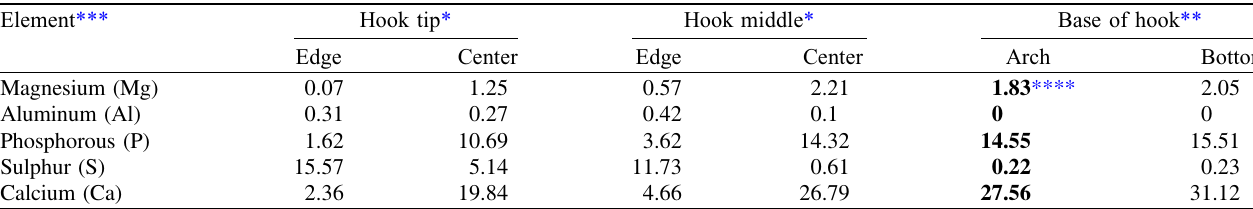
Table 4. Chemical composition of a Gallium (Ga, LMIS) cut of anterior hook of Neoechinorhynchus johnii. Element***